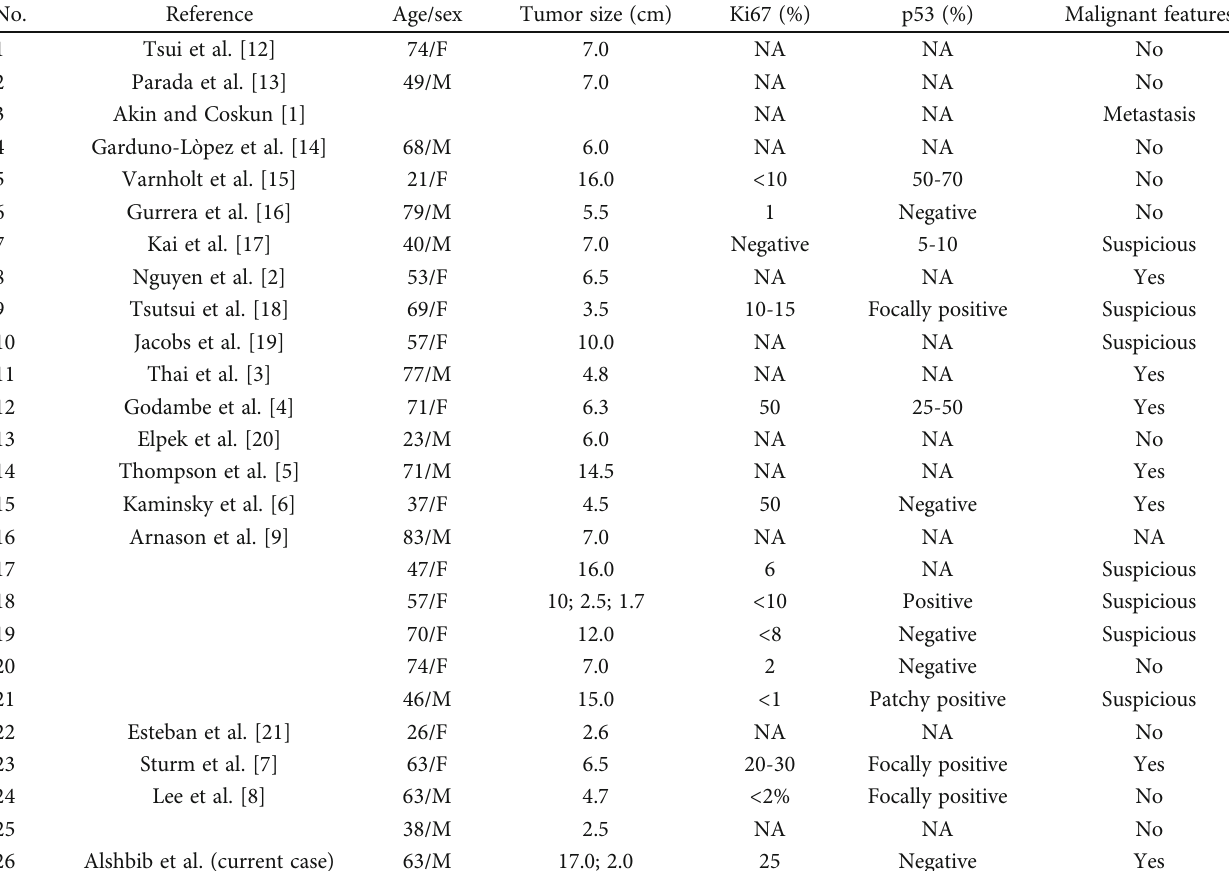
Table 1: Biliary adeno fi broma reported in the